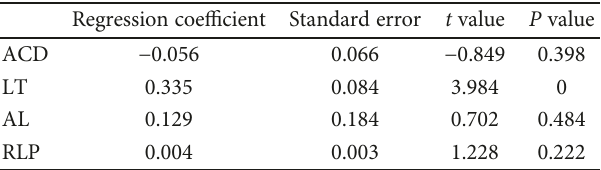
Table 3: Mixed linear regression model of ocular biometry in the APACG associated with RP and APACG